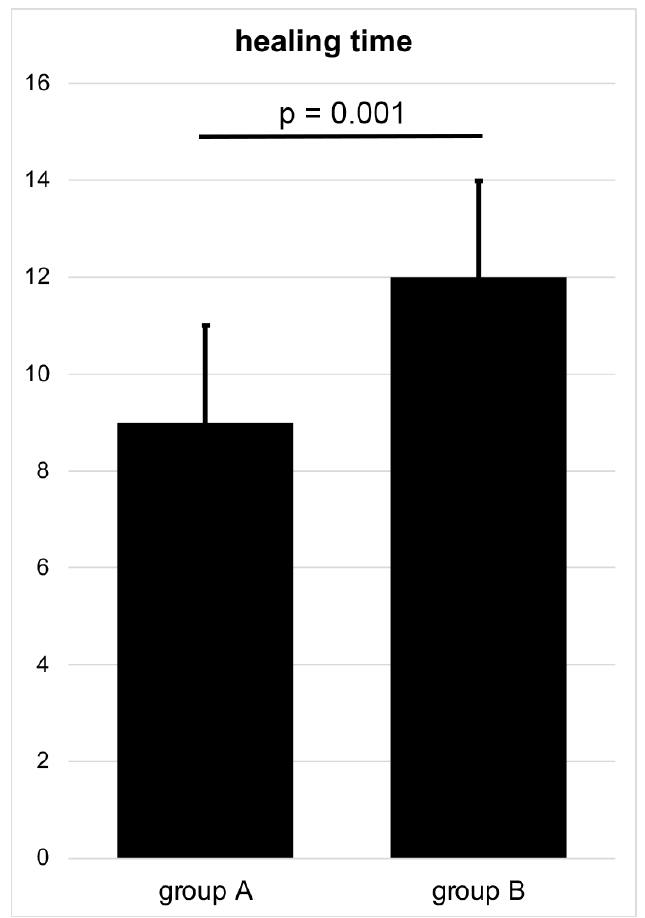
Figure 4. Duration of time to osseous healing after anatomical and valgus reduction stabilized using SHS and ARS (weeks) in a Garden type III femoral neck fracture.